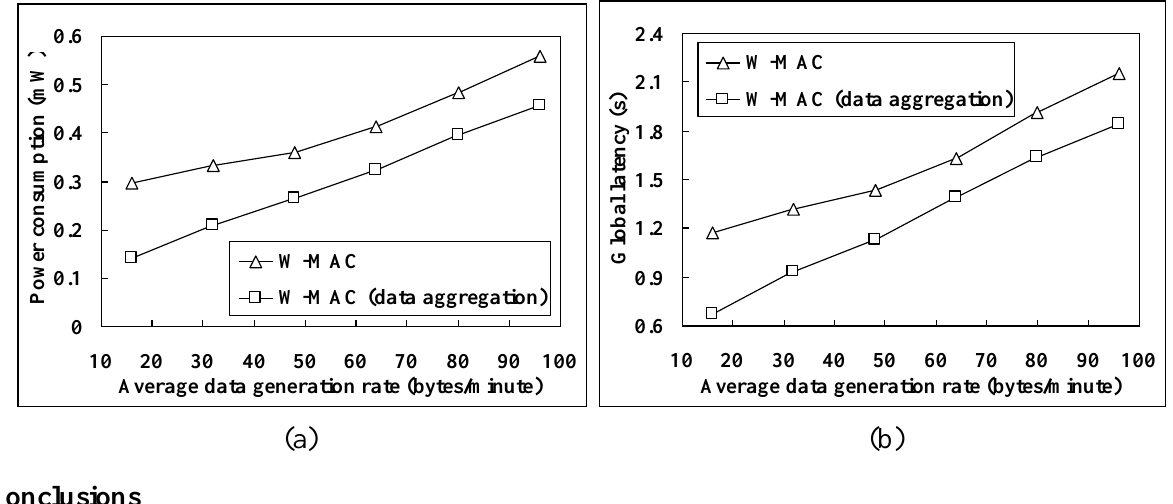
Figure 12. The performance of W-MAC with and without data aggregation: (a) power consumption and (b) global